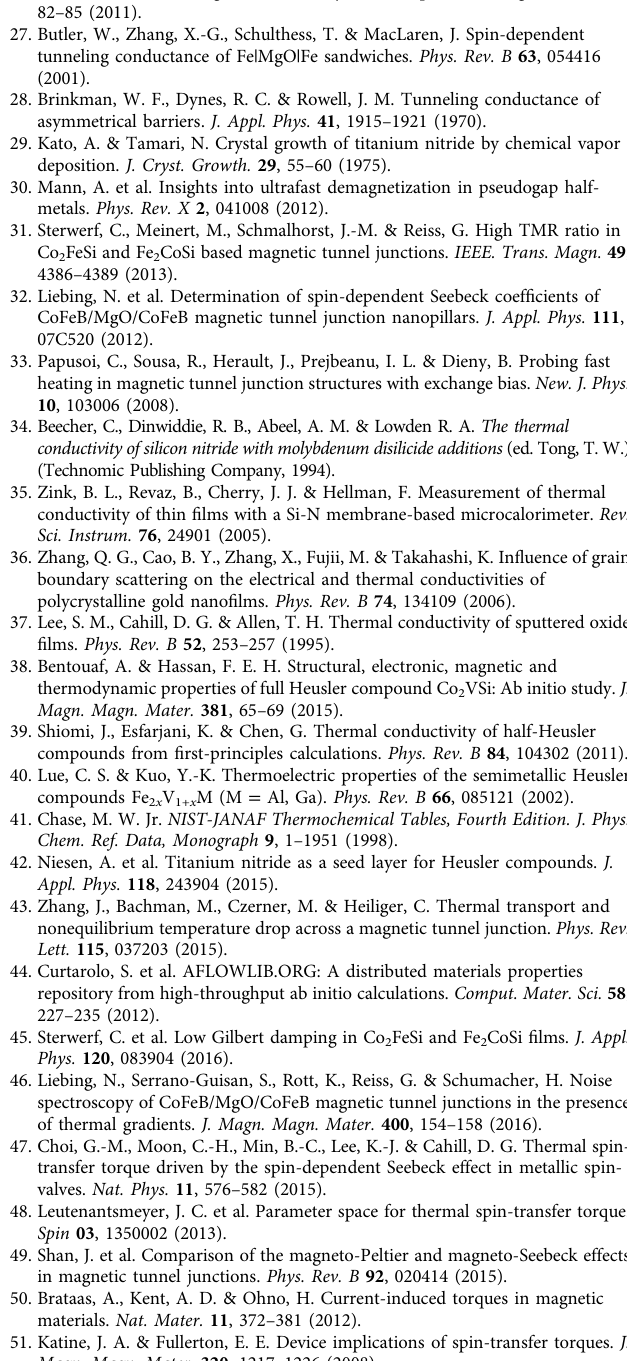
Methods For a detailed explanation of the MTJ preparation, characterization of the MTJs after dielectric breakdown and details on the fi nite element method simulations please refer to the Supplementary Information and refs 5, 31, 42